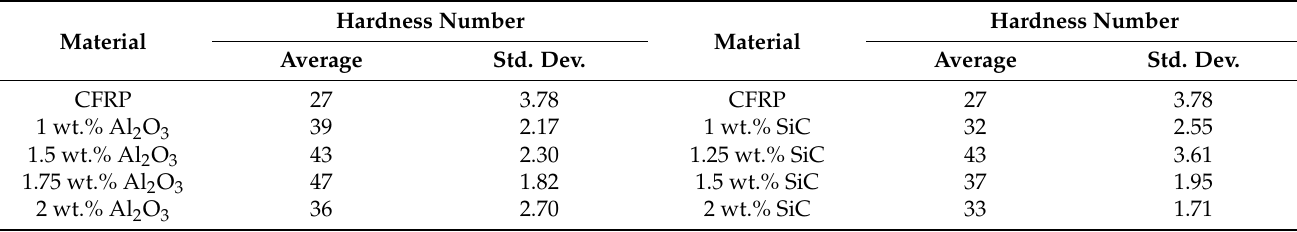
Table 5. Hardness number of CFRP and hybrid nano-composites.